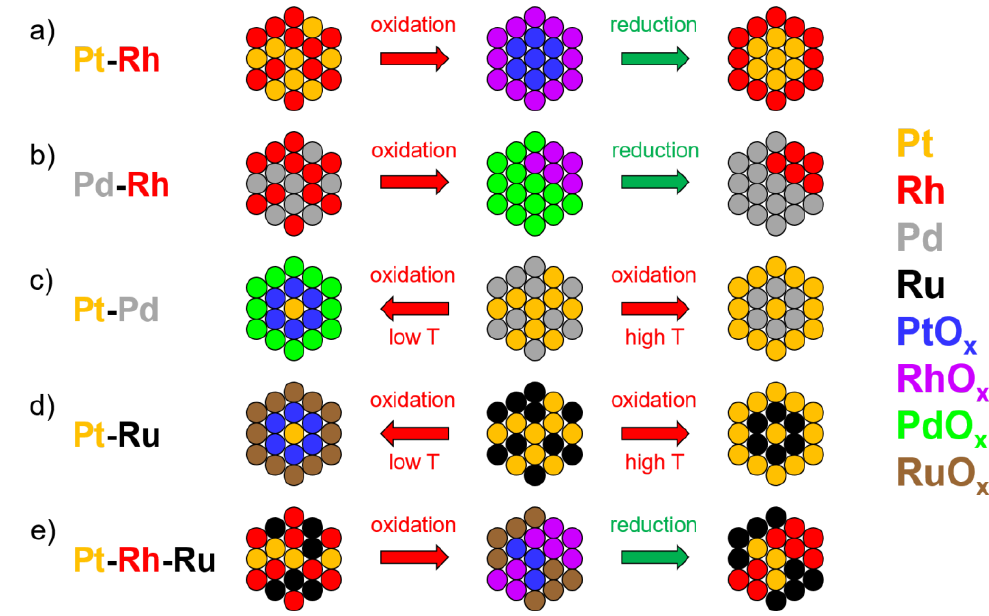
Figure 5. Schematic representation of different behaviors observed upon oxidation and oxidation/reduction cycles allowing for a better engineering of nanoparticles. ( a ) Core-shell formation in the Pt-Rh system; ( b ) phase separation into nanoregions in the Pd-Rd system; ( c ) switch between Pt and Pd enrichment as a function of the temperature in Pt-Pd system; ( d ) switch between Pt and Ru enrichment as a function of the temperature in Pt-Ru system; and ( e ) phase separation in the Pt-Rh- Ru system. Adapted from [113], Copyright (2013), with permission from Elsevier and adapted with permission from [114]. Copyright (2012) American Chemical Society.